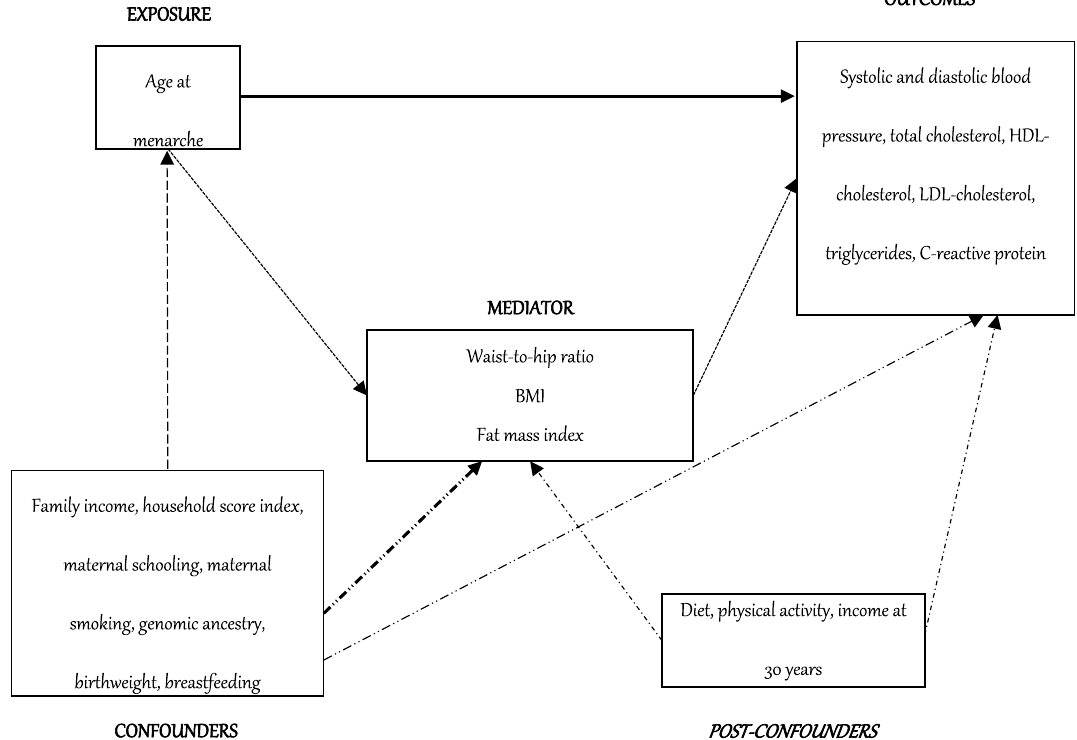
Figure 1. Directed acyclic chart (DAG) representing the influence of mediator and confounding variables in the relationship between age at menarche and metabolic cardiovascular risk